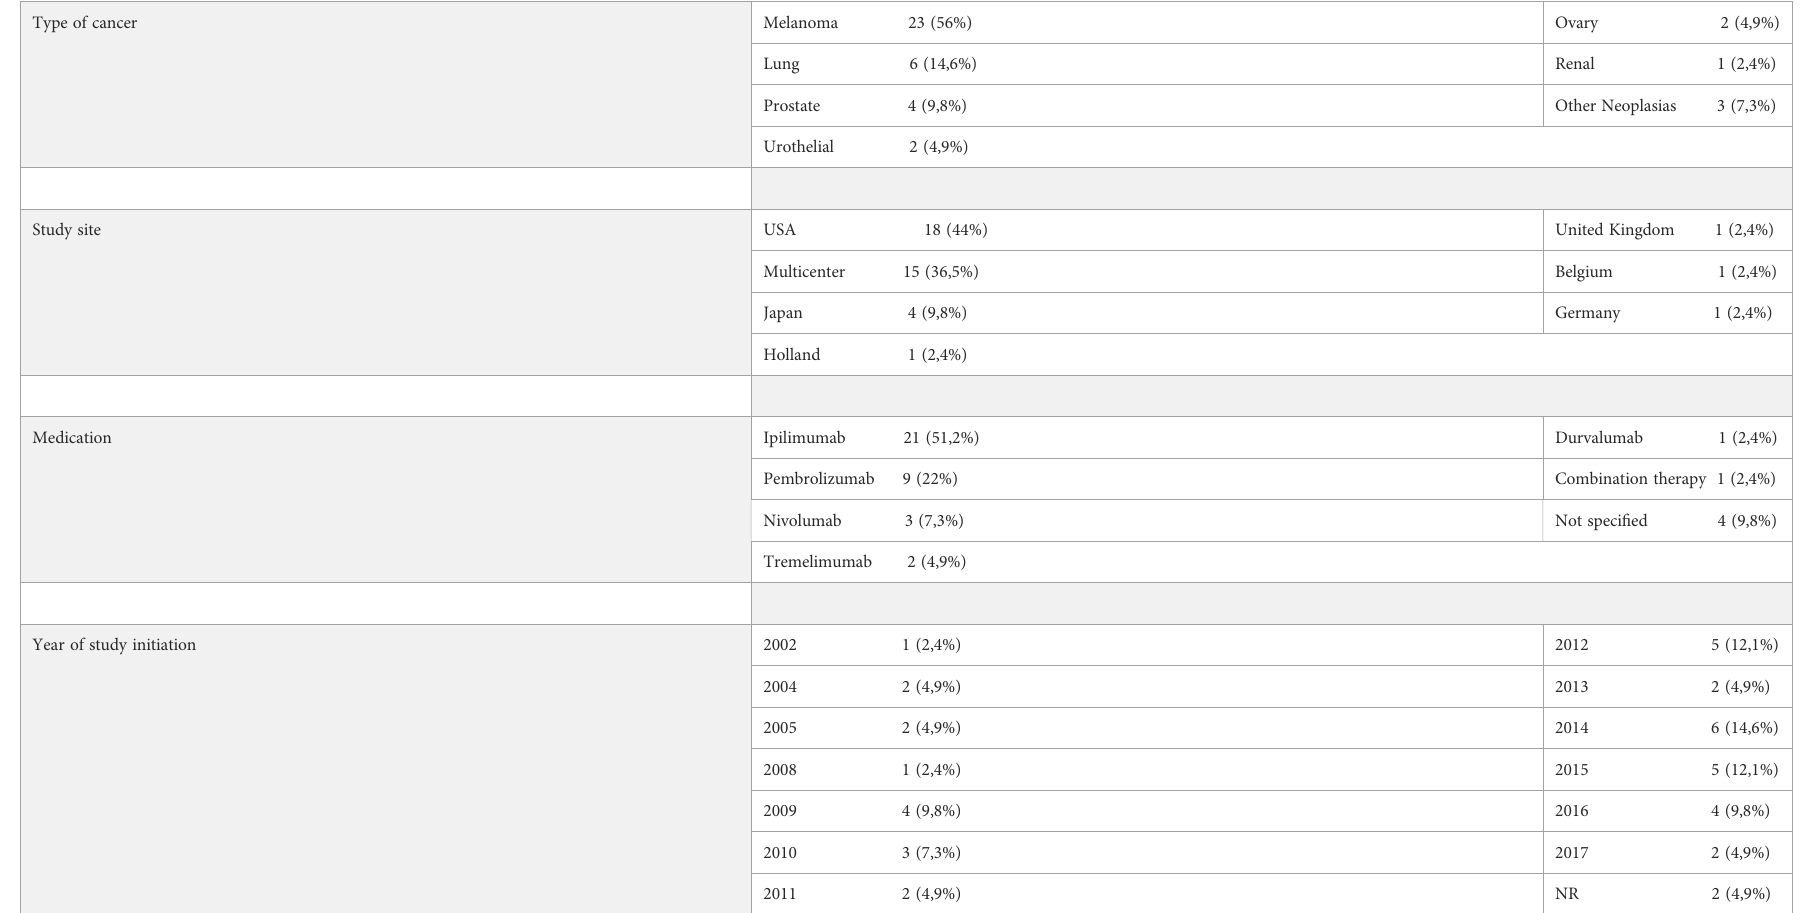
TABLE 2 Distribution of non-randomized clinical trials according to the type of cancer studied, place of study, medication used and year of study